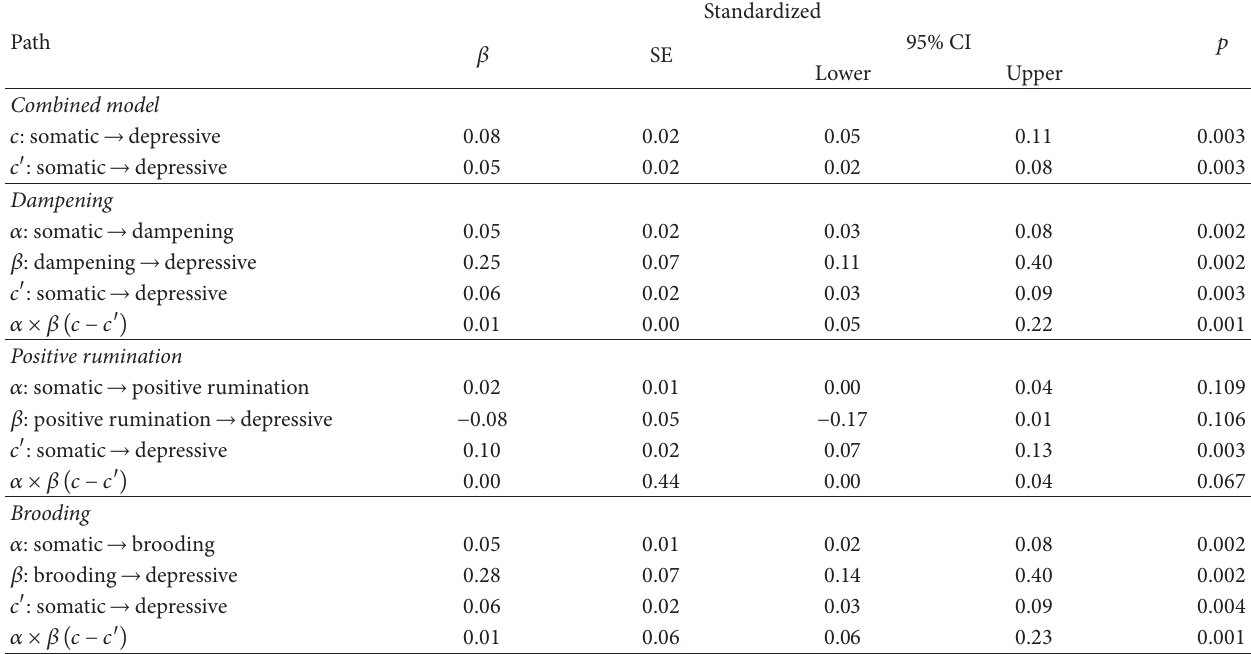
Table 2: Bootstrapping test of mediation effects predicting depressive